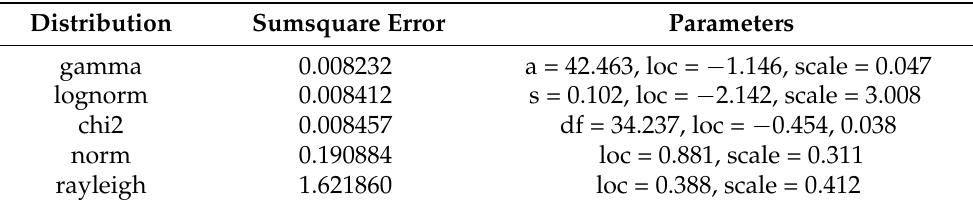
Table 2. Sumsquare error and parameters of different distributions.